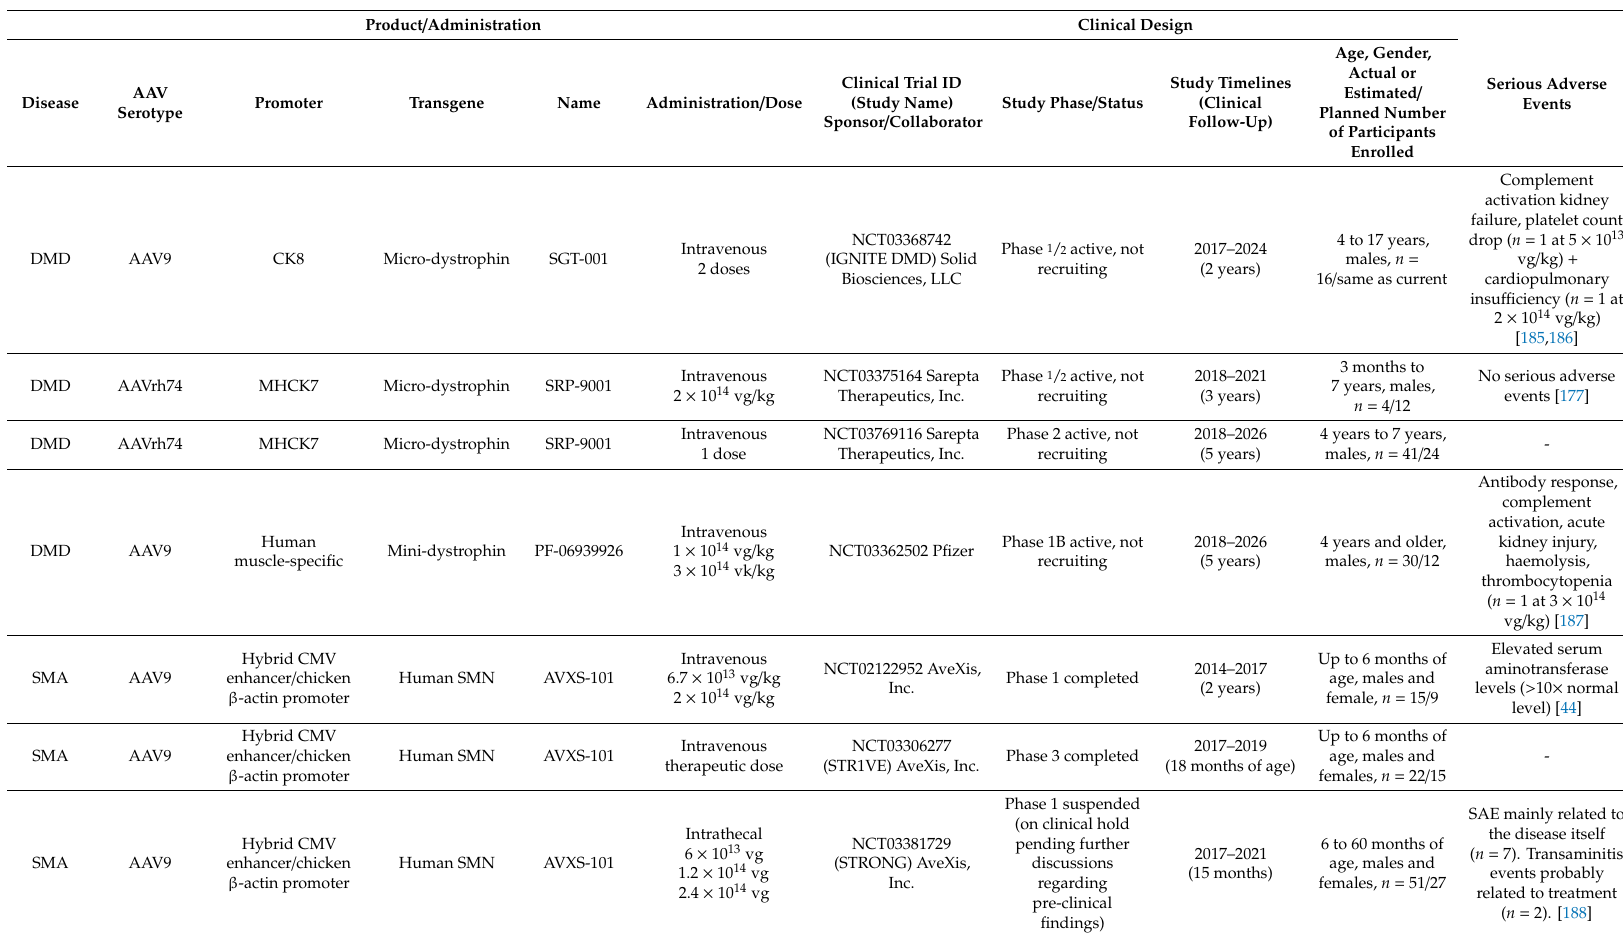
Table 1. Summary of current body-wide and central nervous system (CNS)-targeted adeno-associated virus (AAV)-mediated gene replacement therapy clinical trials for neuromuscular diseases, as reported in ClinicalTrials.gov